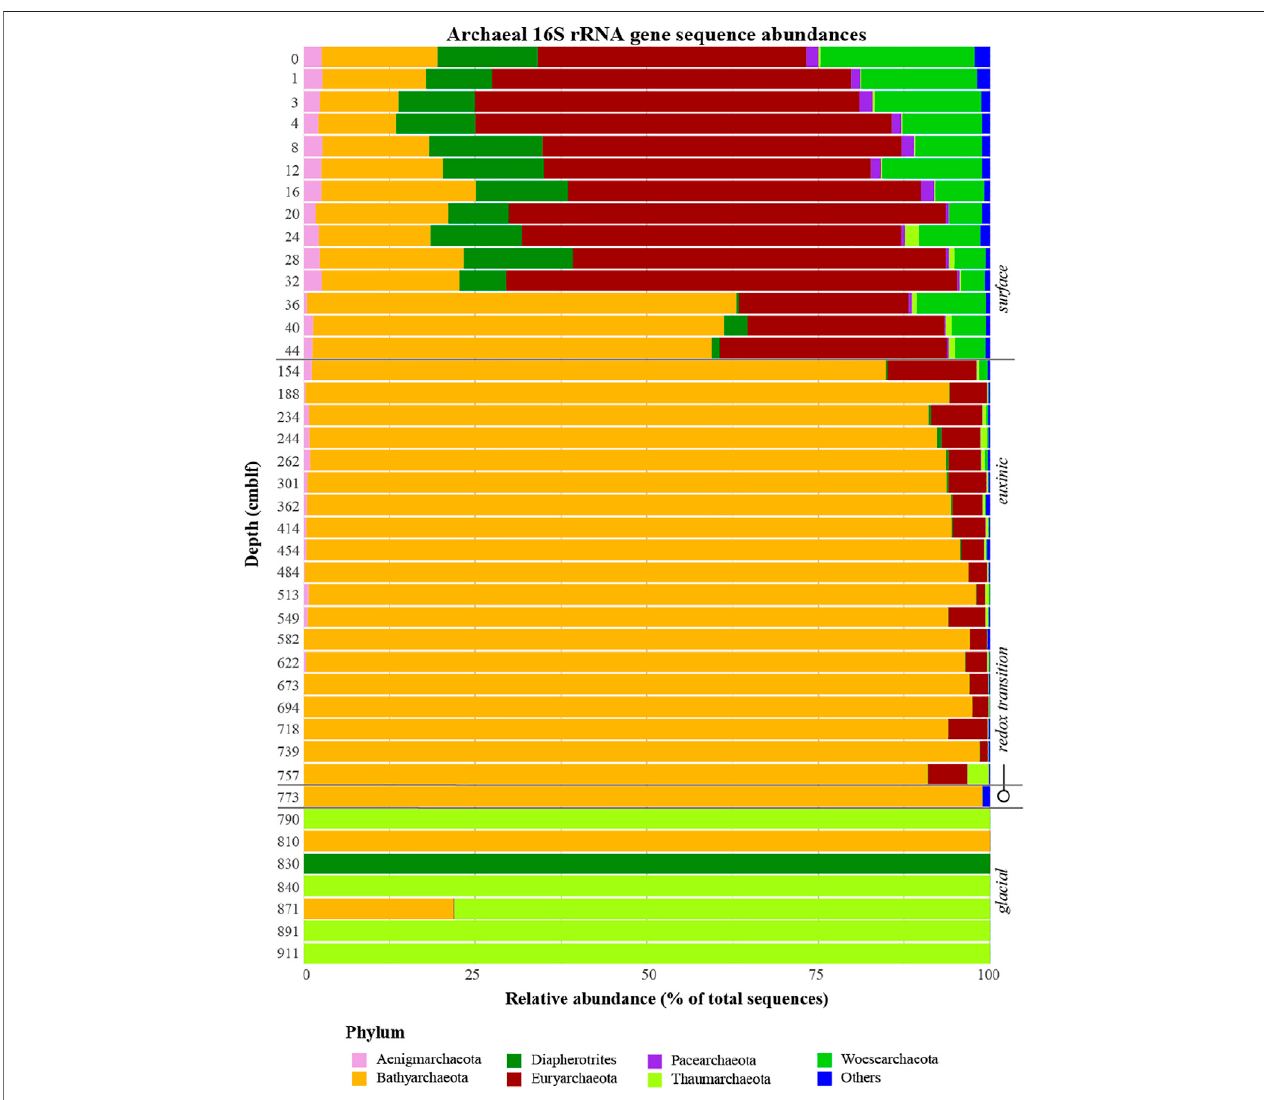
FIGURE 6 | Relative abundances of Archaeal 16S rRNA gene sequences with depth. Sediment geological transitions are indicated on the right.